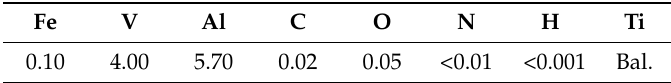
Table 1. Chemical composition of Ti-6Al-4V titanium alloy (wt.%).